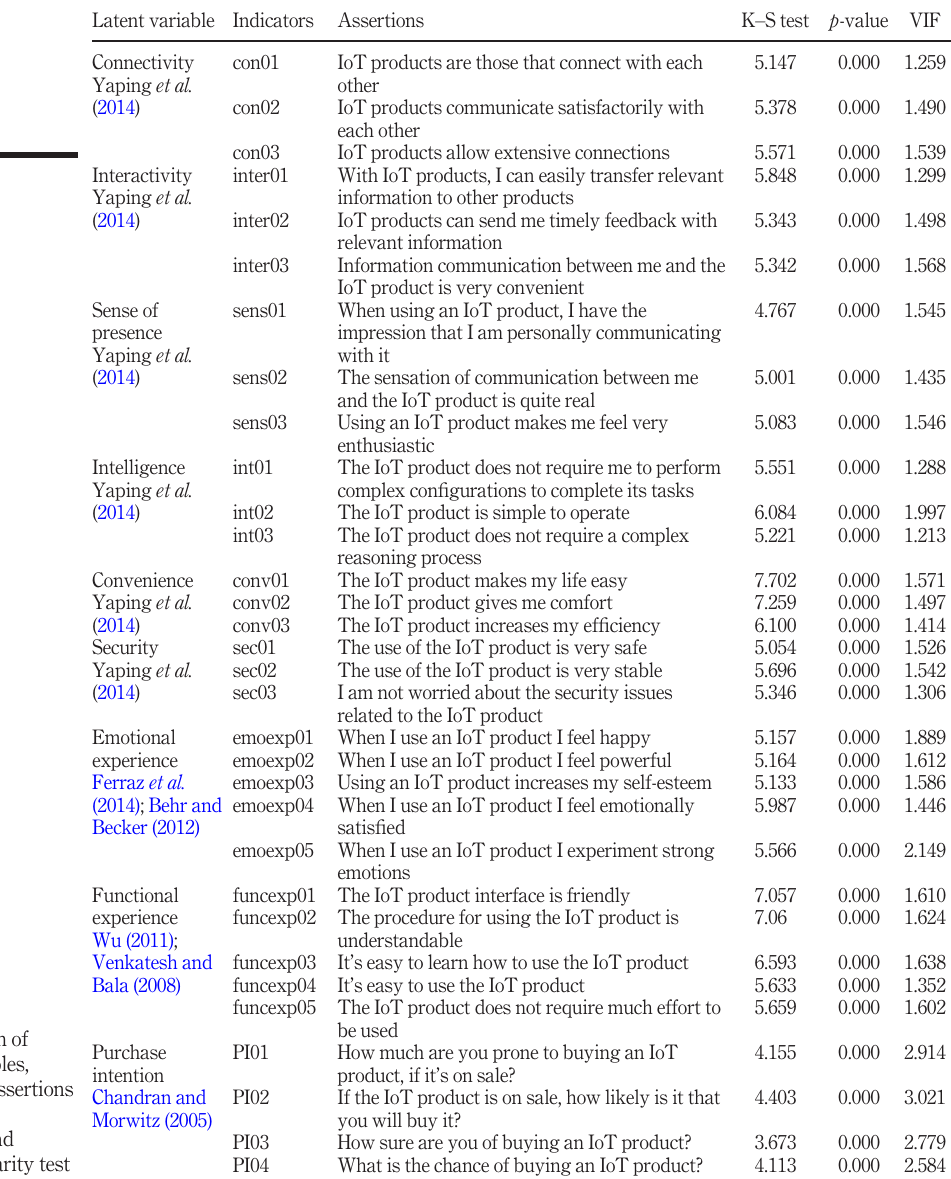
Table AI. Identi fi cation of latent variables, indicators, assertions description, normality and multicollinearity